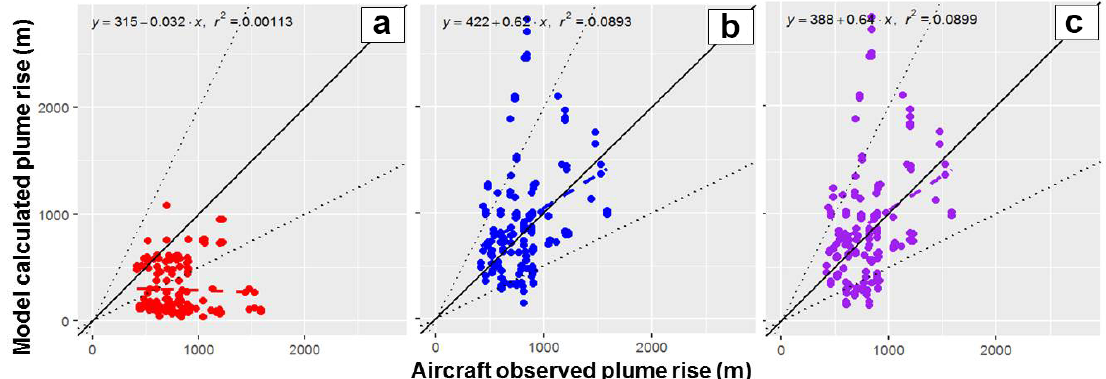
Figure 8. Observed plume-rise heights during aircraft emission box flights compared to model calculated plume-rise using (a) the original plume-rise algorithm, (b) new plume-rise algorithm, and (c) new plume-rise algorithm and CEMS hourly stack temperature and volume flow rate. Table 7. Comparison of model plume-rise performance. Number (model:observed) Original plume- New plume-rise algorithm New plume-rise algorithm rise algorithm (layered approach) driven by CEMS